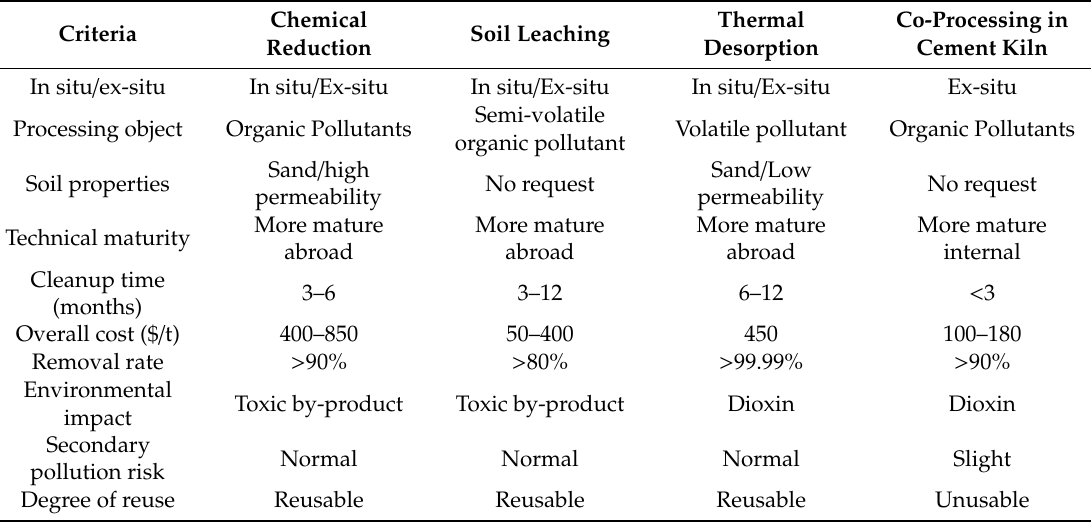
Table 1. Information for the remediation technology options.